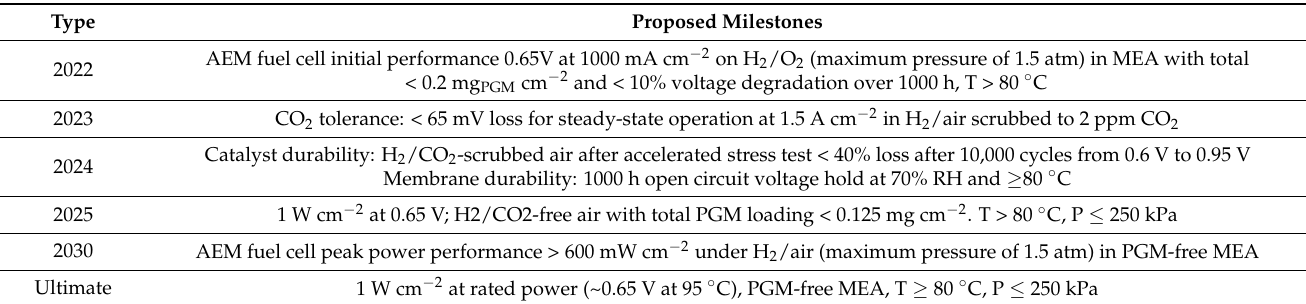
Table 11. Organized by DoE, the target strategy for each year is given for the standardization of AEMFC